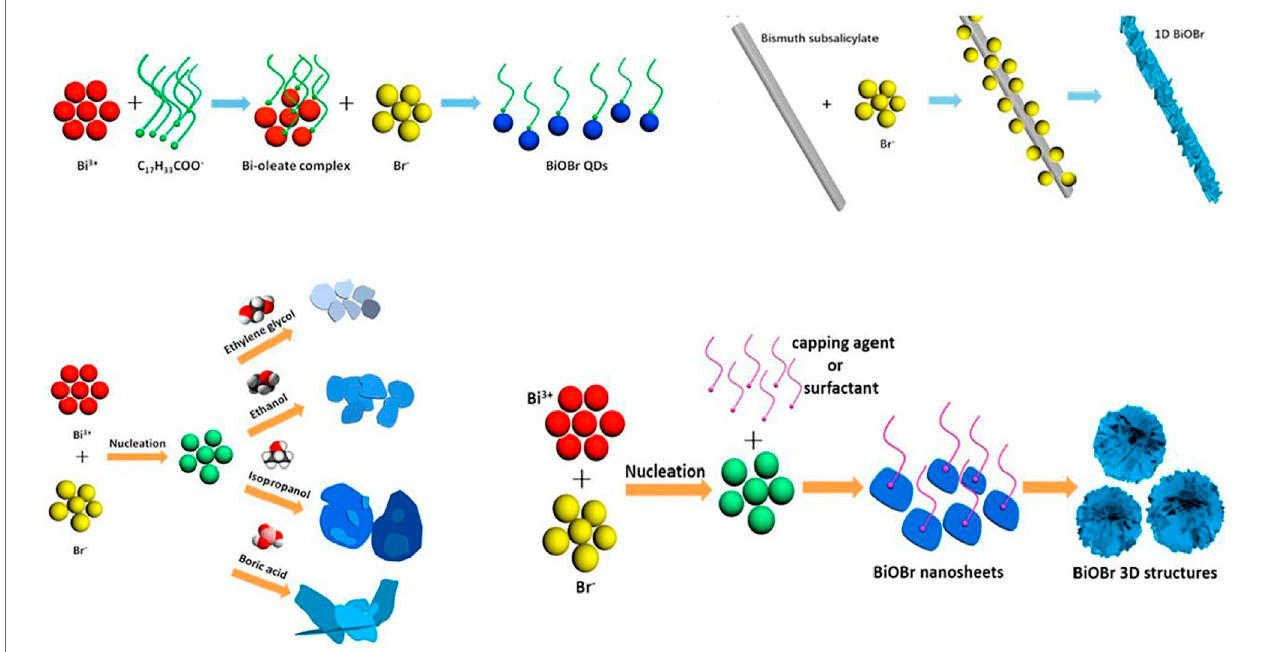
FIGURE 4 | Schematic map of the probable formation of 0D, 1D, 2D, or 3D BiOBr (Modi fi ed from Ref (Han et al., 2020)).